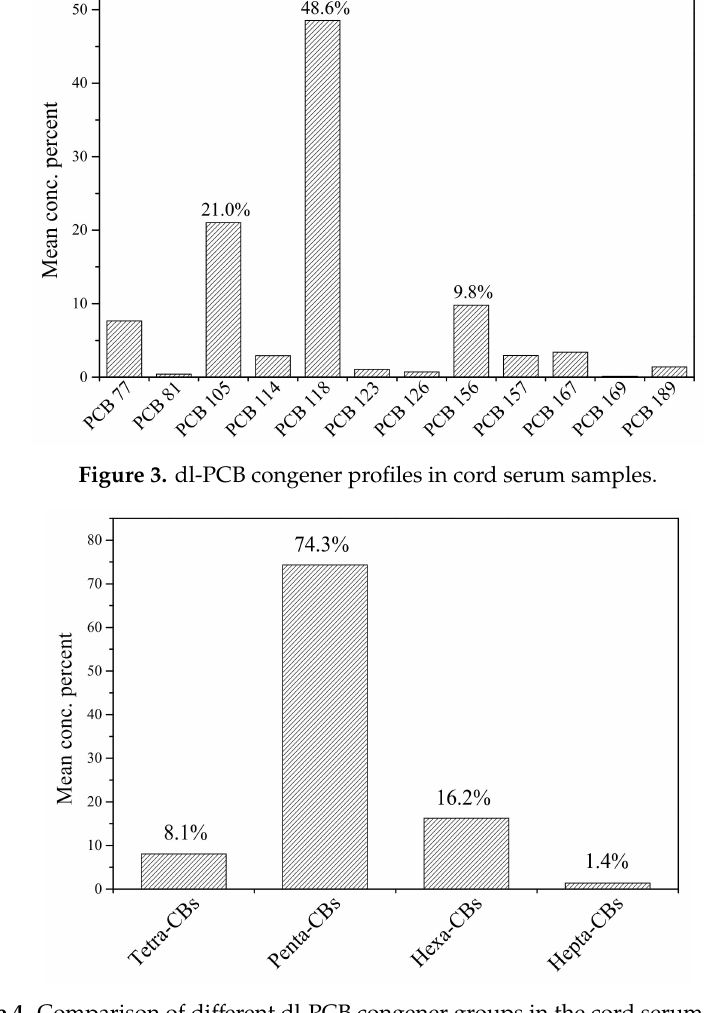
Figure 4. Comparison of di ff erent dl-PCB congener groups in the cord serum